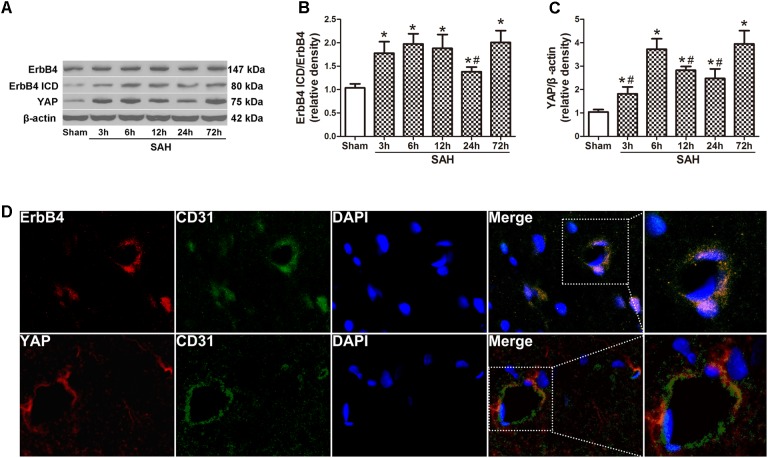
Expression of endogenous ErbB4, ErbB4 ICD and YAP after subarachnoid haemorrhage (SAH) induction. Representative Western blot bands of ErbB4, ErbB4 ICD and YAP from the ipsilateral hemisphere after SAH (A), quantitative analyses of ErbB4 ICD/ErbB4 (B) and YAP (C) expression. n = 6. Double immunostaining showed that both ErbB4 and YAP were colocalized with CD31-positive endothelial cells at 24 h after SAH (D). n = 2, ∗p < 0.05 versus sham; #p < 0.05 versus 72 h.